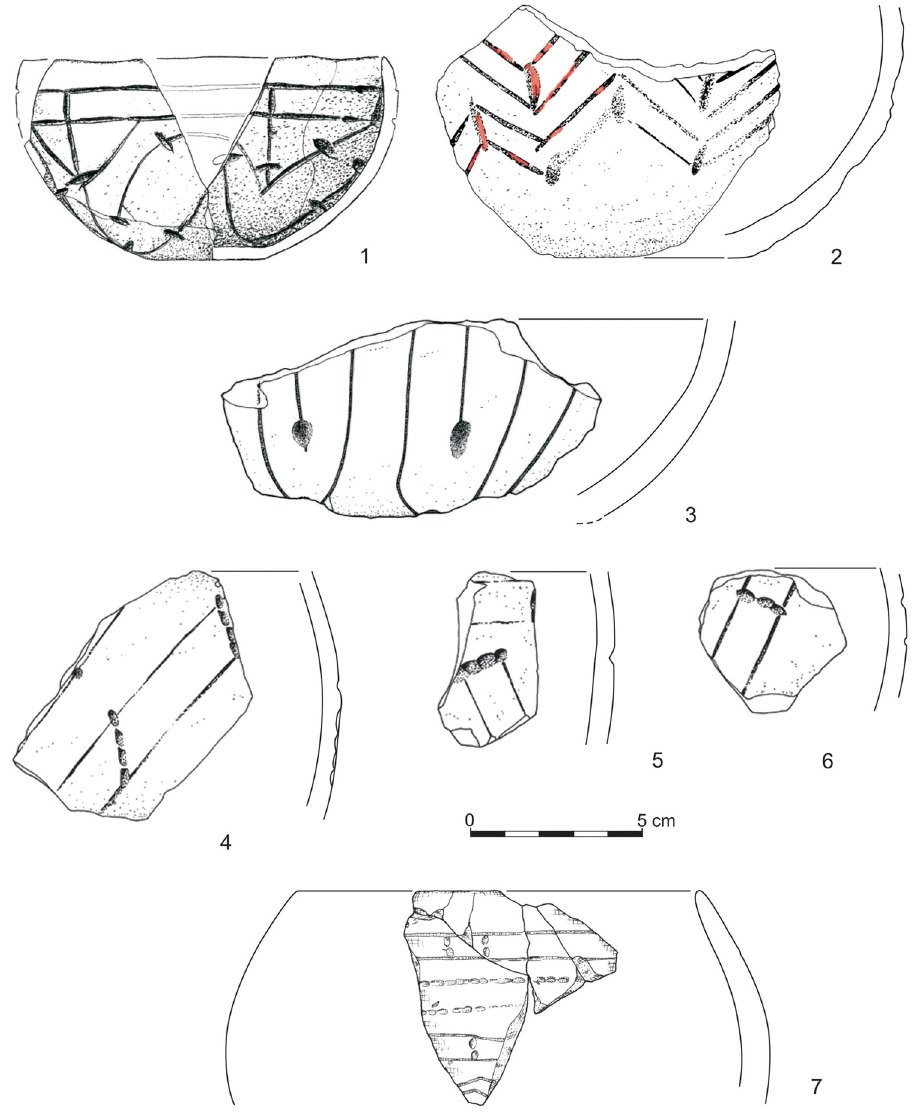
Figure 3: Music note ( 4 ) , Ž eliezovce ( 1, 2, and 5 – 7 ) , and LBK pottery inlaid with white paste Bükk Culture pottery ( 3 ) from Wi ś nicz Foothill. Ł oniowa, com. D ę bno, site 18: 1, ( 3 ) feature 8; ( 4 ) feature 155; Ż erków, com. Gnojnik, site 1: 2 ( inlaid with red paste ) , ( 5 – 7 ) feature